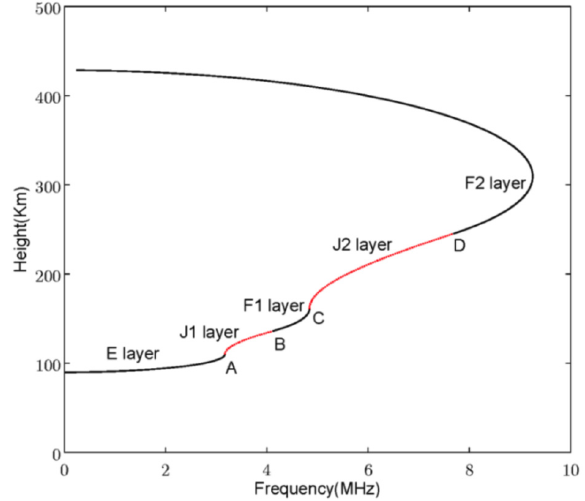
Figure 1. MQP ionosphere